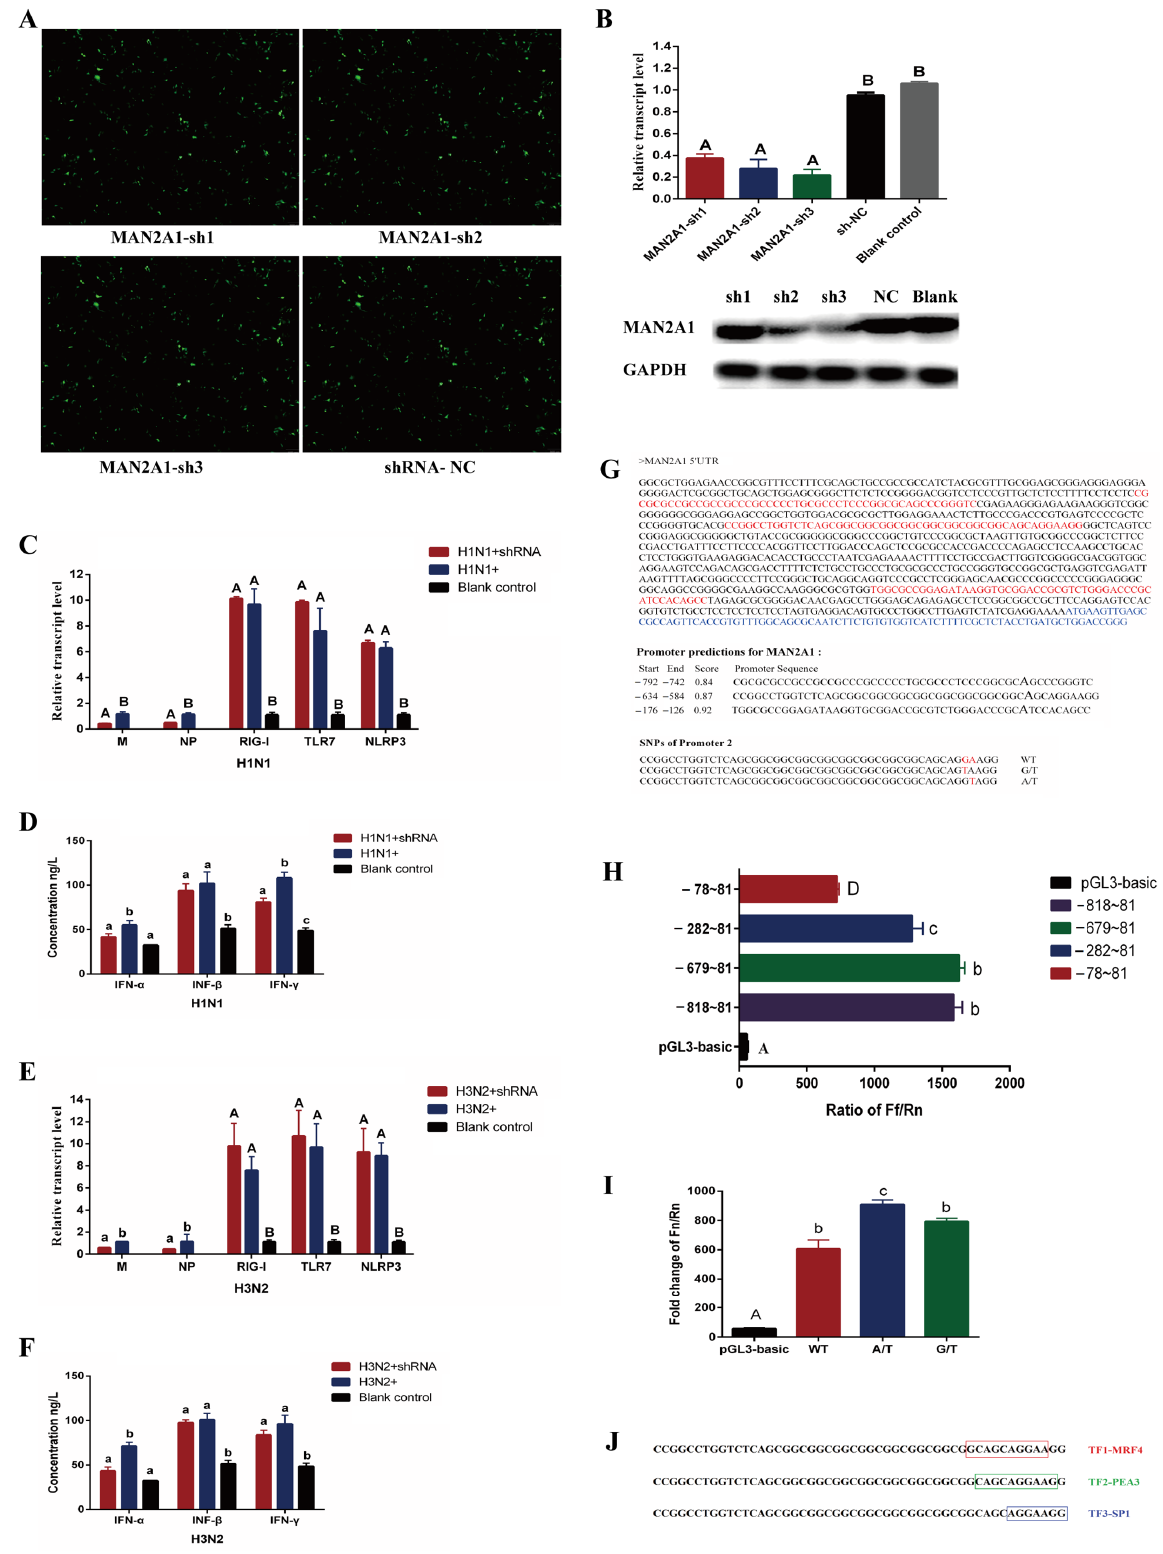
Figure 5. The regulatory role of MAN2A1 gene in the process of H1N1 and H3N2 infecting 3D4/21 cells. ( A ) represents fluorescence expression of 3D4/21 cells transfected by MAN2A1 interference vectors. ( B ) represents the qPCR and Western blot results of the MAN2A 1 gene in 3D4/21 cells transfected by MAN2A1 interference vectors. Different lowercase letters indicate significant differences ( p <